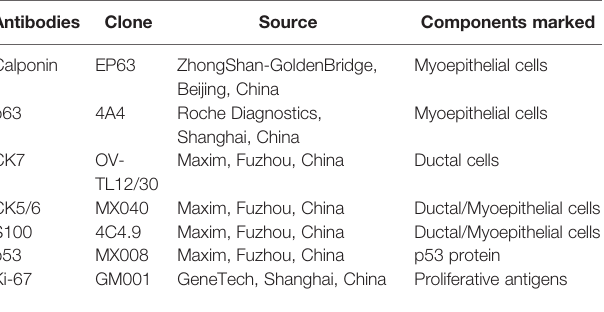
TABLE 1 | Antibodies for immunohistochemical